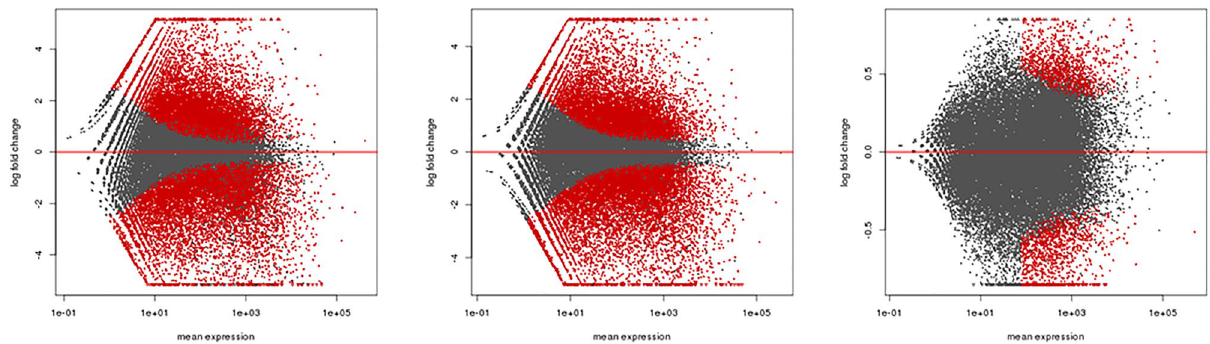
Figure 4. MA plots of differentially expressed genes (red points) and nondifferentially expressed genes (black points). The X axis is the mean expression, represented as gene expression abundances. The Y axis is the log 2 of the gene differential expression multiplier, which indicates the log ratio. ( a ) MA plot of DEGs in CK1 vs. CK2, ( b ) MA plot of DEGs in MT1 vs. MT2, ( c ) MA plot of DEGs in CK2 vs. MT2.